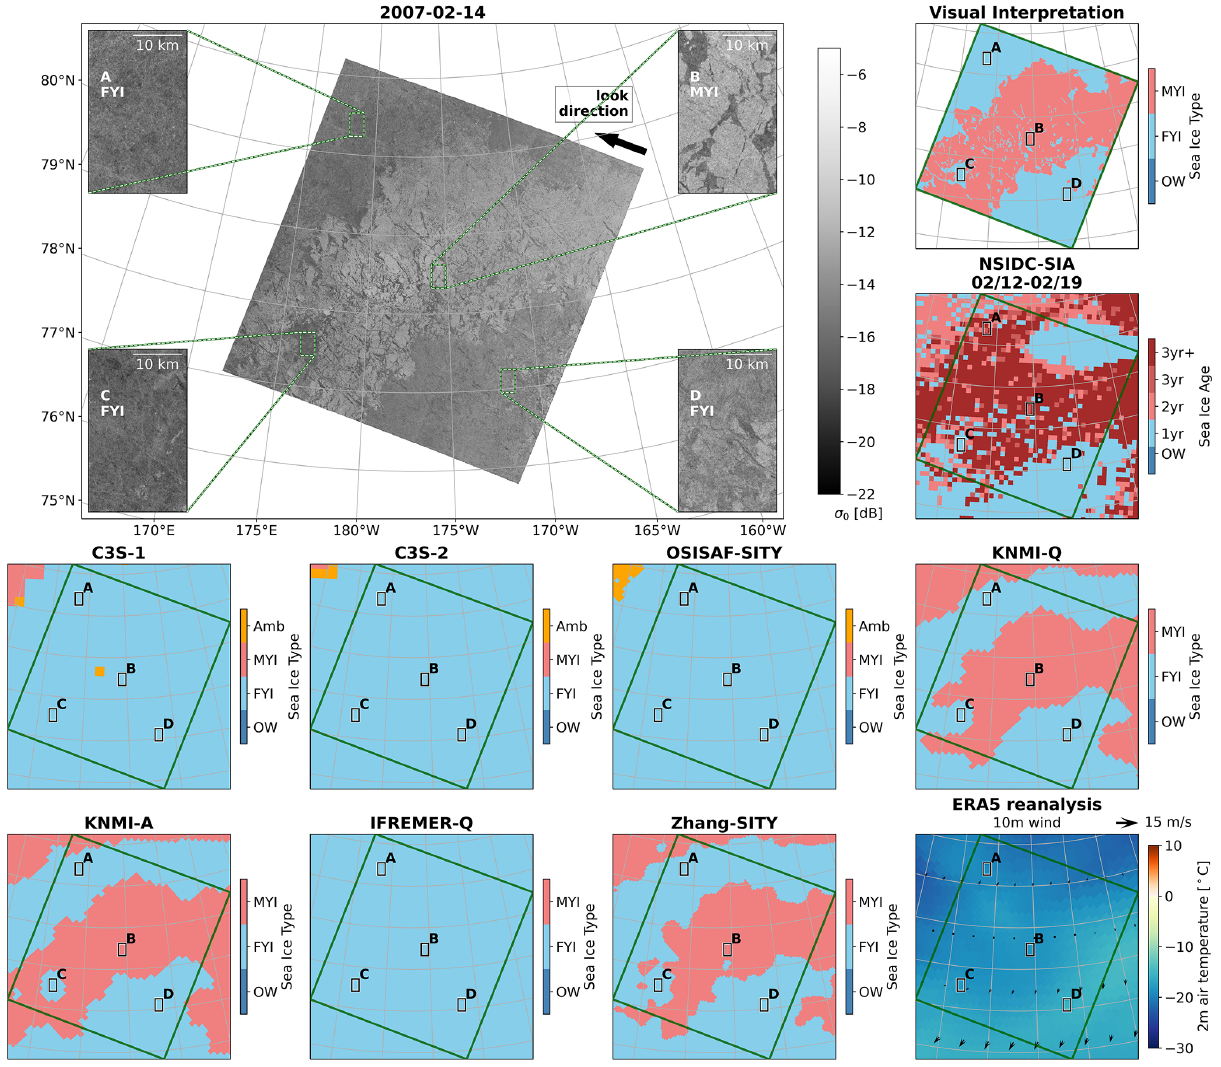
Figure 11. RS-1 image, ice type distribution from seven SITY products (C3S-1, C3S-2, OSISAF-SITY, KNMI-Q, KNMI-A, IFREMER-Q and Zhang-SITY), weekly NSIDC-SIA product and visual interpretation result based on the SAR image, along with 2m air temperature and 10m wind from ERA5 reanalysis on 14 February